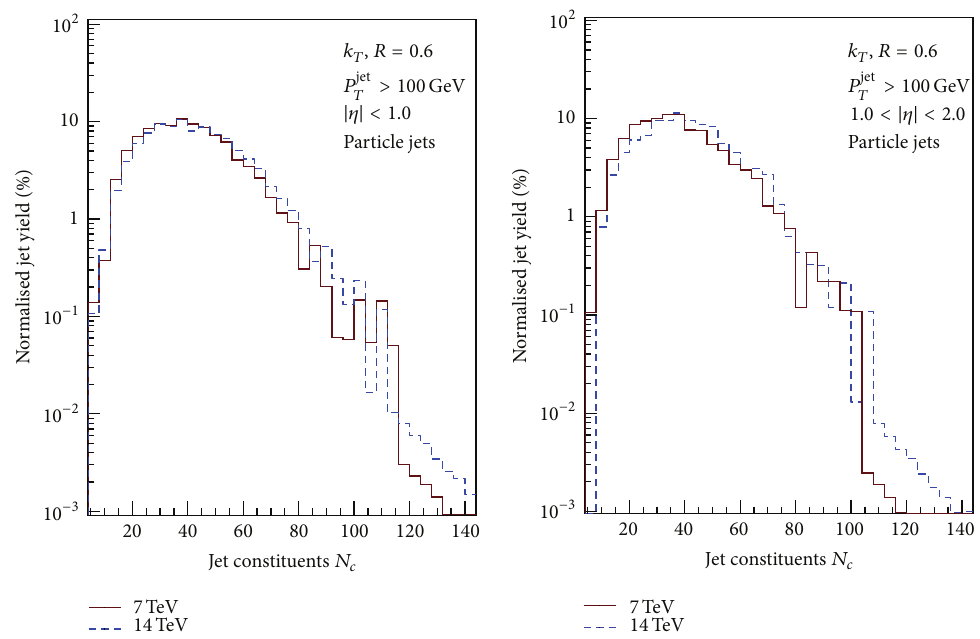
Figure 3: Distributions of the jet constituent multiplicity in particle jets having 𝑃 jet 𝑇 > 100 GeV from 𝑘 𝑇 algorithm at √𝑠 = 7 TeV compared to √𝑠 = 14 TeV in the pseudorapidity bins of |𝜂| < 1 and 1 ≤ |𝜂| < 2 .